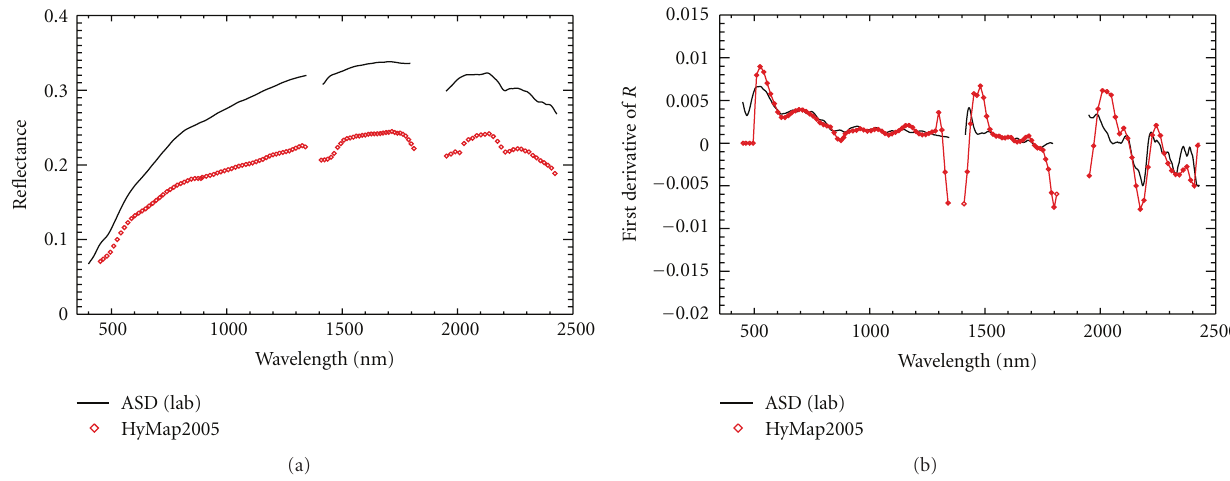
Figure 3: Reflectance (a) and first derivative of the reflectance (b) of one sampling point as measured under laboratory conditions (black solid line) and by the HyMap imaging spectrometer on May 27, 2005 (red solid line with diamonds indicating centre wavelengths). The soil was classified by soil analysis as a sandy loam with 10.4 g OCkg − 1 .